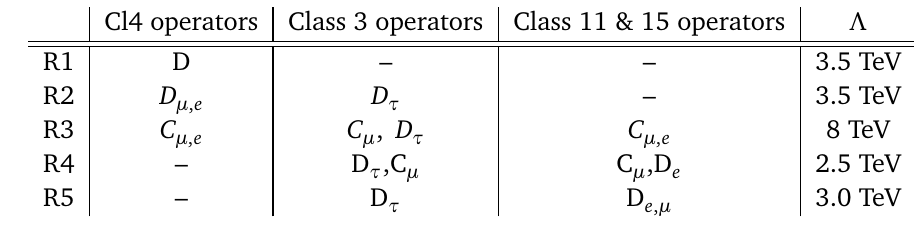
Table 4: Summary of the dominant operator contributions under the assumption the Class 4 operators are generated at one loop. D nates for flavor i , D indicates for all flavors. C contribution and that the marked classes are of comparable